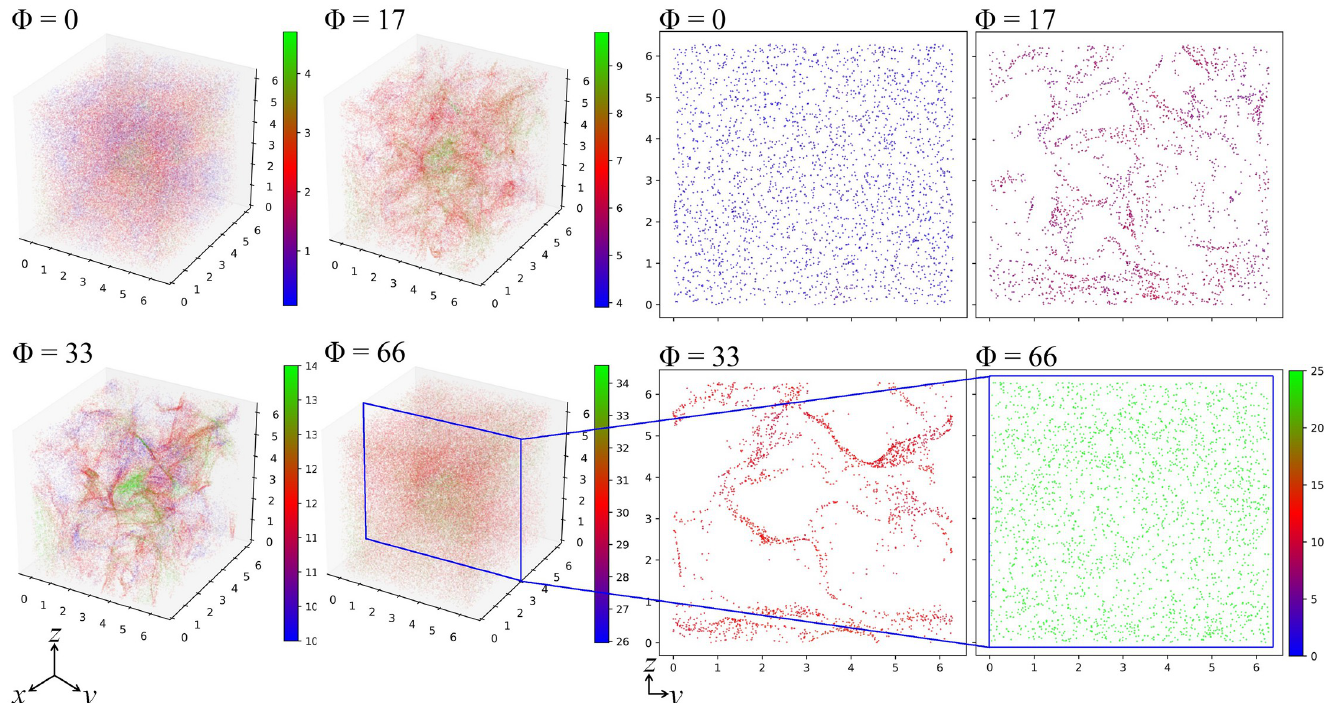
Fig 2. Cluster formation of swimming particles. Snapshots of the distribution of particles when Re λ = 59 for swimming numbers F = [0, 17, 33, 66], where the swimming number F = 0 corresponds to tracer particles. Colors correspond to the swimming speed of the particles.